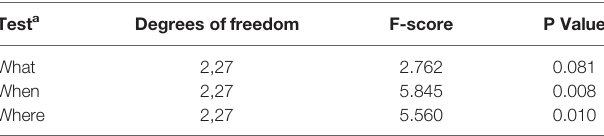
TABLE 1 | MANOVA results for “ What ” , “ Where ” , and “ When ” preference scores.